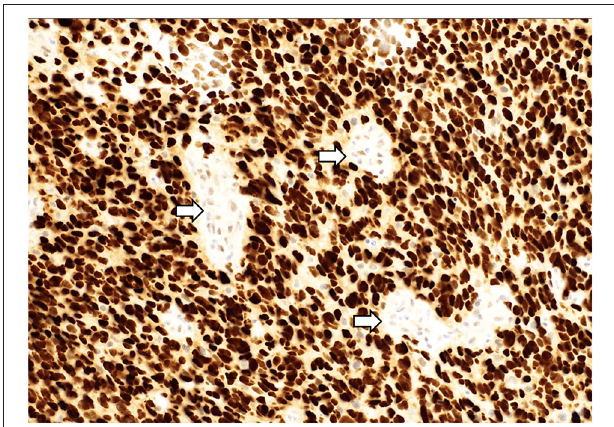
FIGURE 5 | Diffuse midline glioma, H3K27M-altered demonstrating diffuse nuclear staining for H3K27M with negative endothelial cells serving as an internal control (arrow). H3K27M immunostain, 200x magnification.